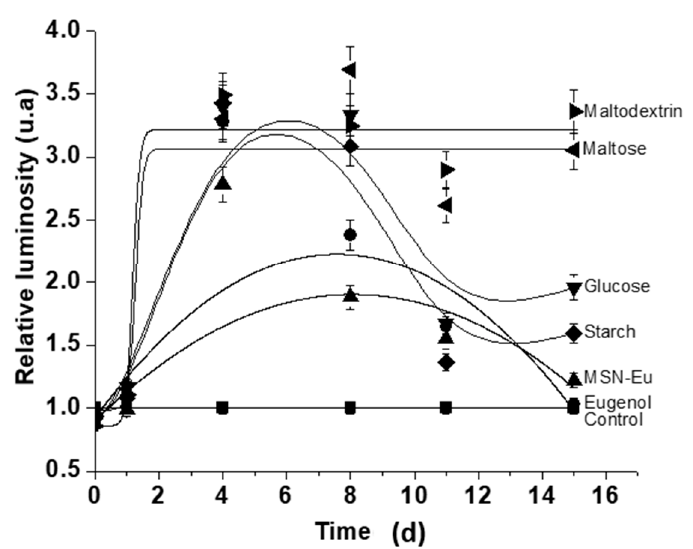
Figure 6. The degree of antifungal activity according to luminosity measurement for 15 d. The values are the ratios of the respective material to the growth control. The higher the relative luminosity, the greater the difference in inhibition compared with the growth control.